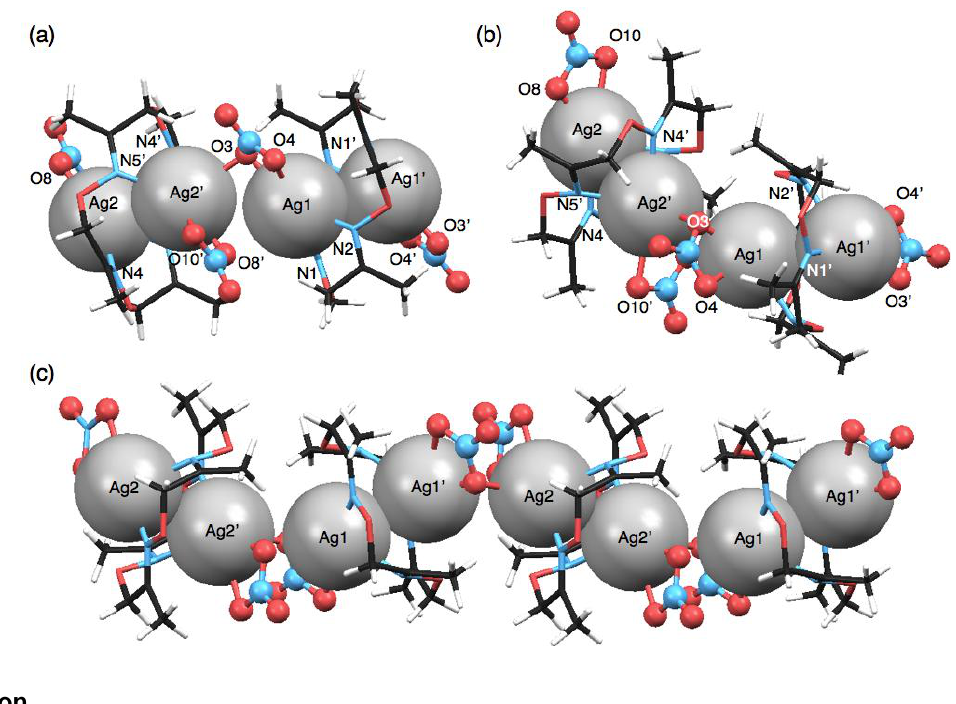
Figure 6. Polymeric structure of [Ag ( b ) a side view of a crookedly connected structure containing two [Ag and ( c ) a polymeric structure represented with space fill (Ag), stick ( 1 ) and ball-stick (counter anions)